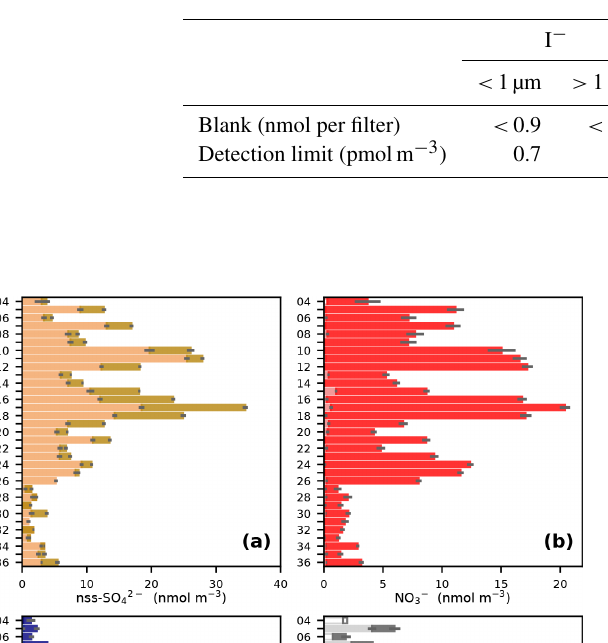
Table 1. Blanks and detection limits for aerosol iodine species for AMT21. Values are given for fine ( < 1µm) and coarse ( > 1µm) aerosol size fractions. Detection limits are presented for an air volume of 1400m 3 , representative of the ∼ 24h sample collection used for most of the samples.